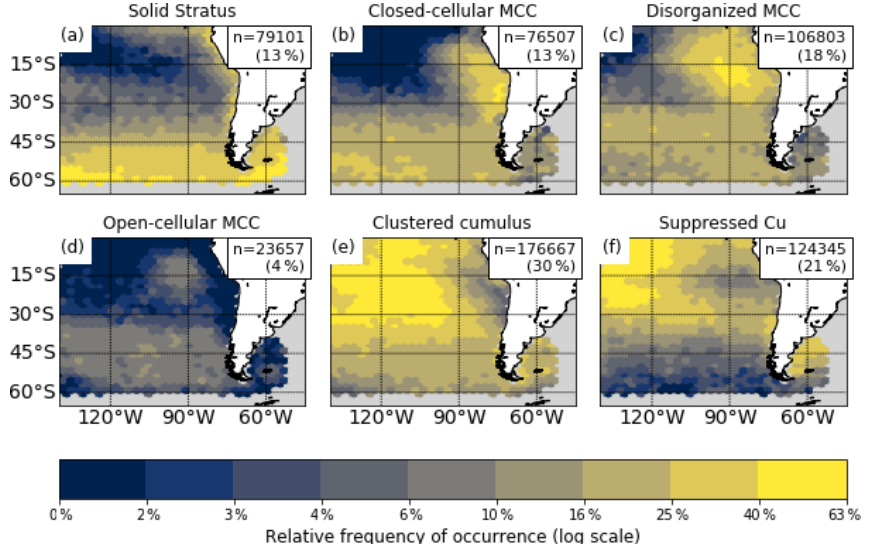
Figure 3. Relative frequency of occurrence of each cloud type on a logarithmic scale. In the upper right corner of each panel, the total number of classifications over 3 years (2014–2016) as well as the total fraction of scenes of each type is shown. Gray areas are where fewer than 200 scenes are